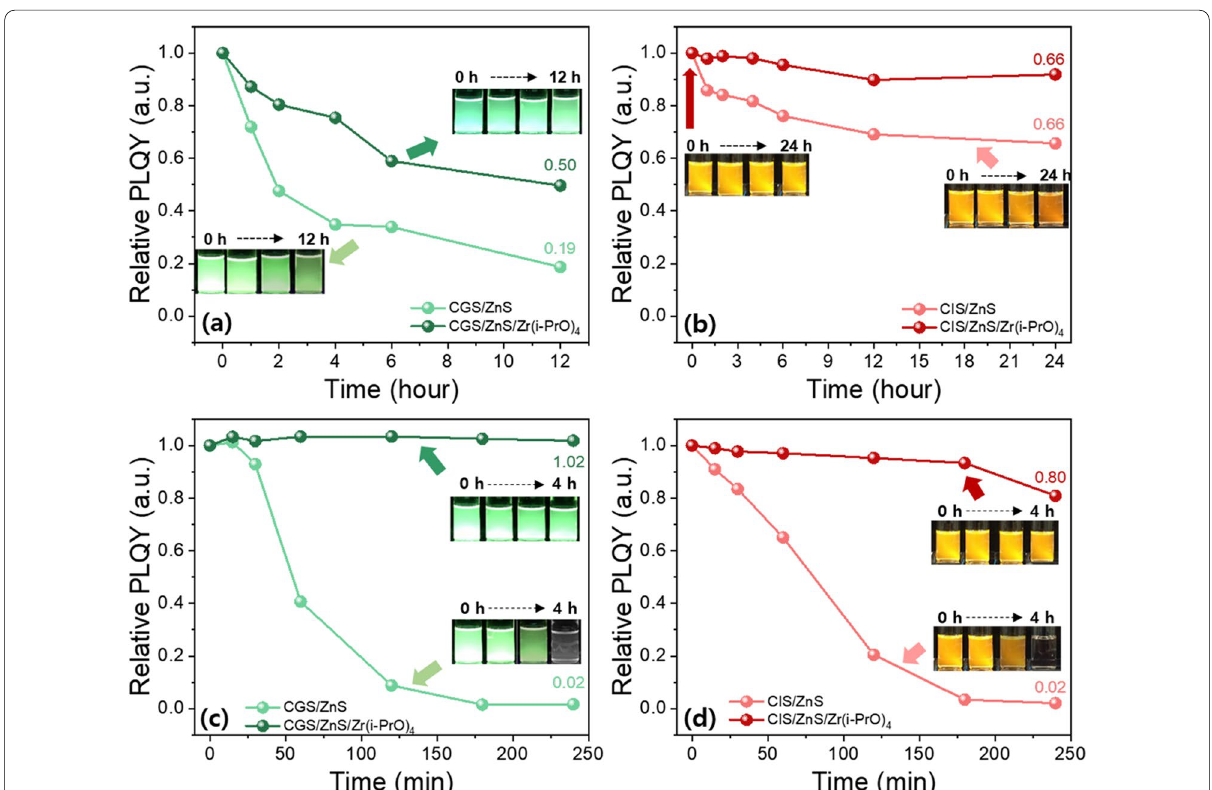
Fig. 5 Relative PLQY values from photostability tests of a green CGS/ZnS based solutions and b red CIS/ZnS based solutions under UV (365 nm) irradiation. Relative PLQY values from thermal stability tests of c green CGS/ZnS based solutions and d red CZS/ZnS based solutions under 150